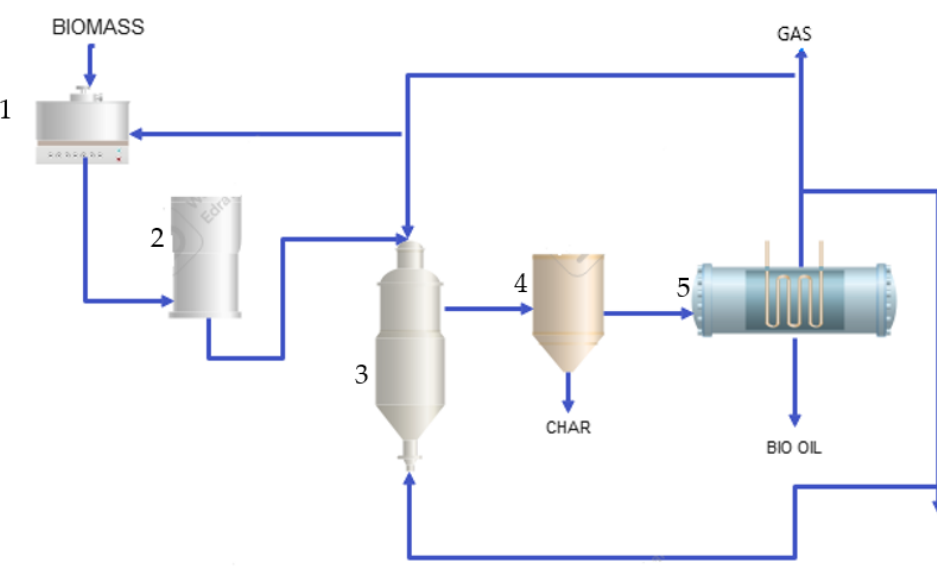
Figure 3. Pyrolysis reactor scheme, own source based on the diagrams in [94,95]. 1. Dry; 2. Grind; 3. Pyrolysis reactor; 4. Cyclone 5. Cool and collect.